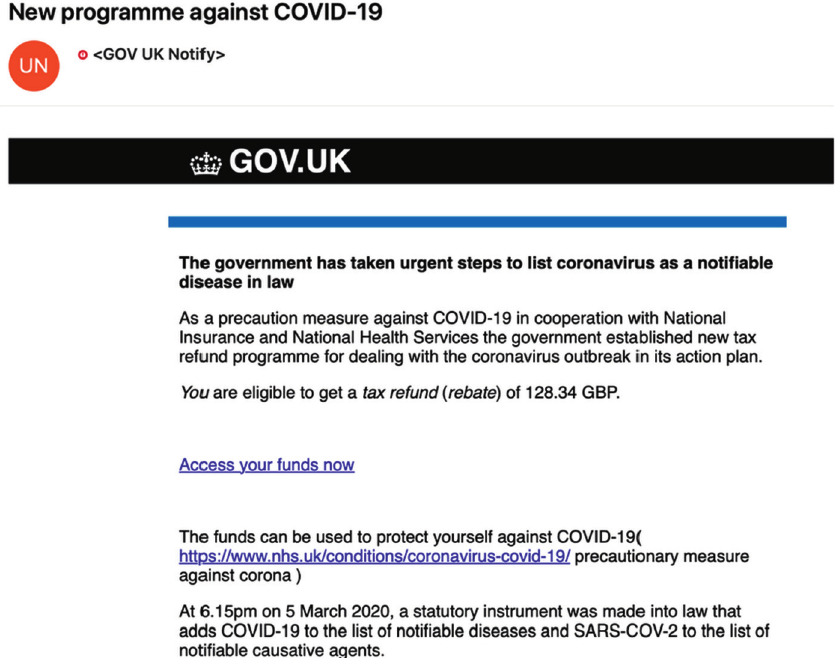
Figure 11: Email misled the recipient to access a website that collects his/her personal identifying information (PII) [48].